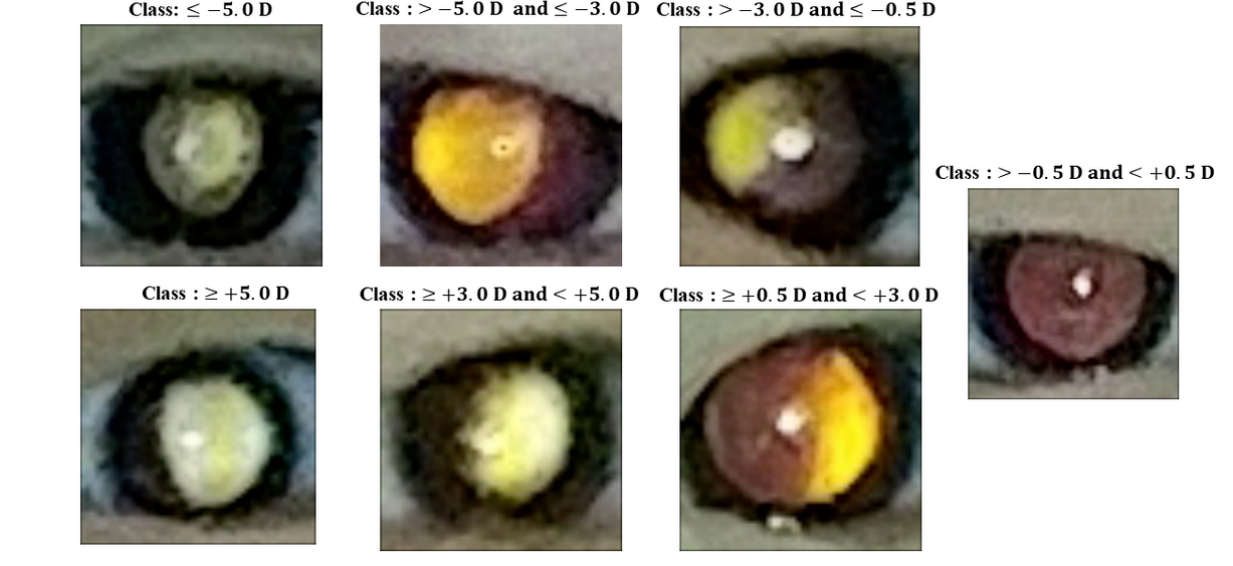
Figure 3. Examples of photorefraction images from the seven different refractor error classes. A bright crescent appears in the pupillary reflex, and its size and shape indicate the diopter (D) value.